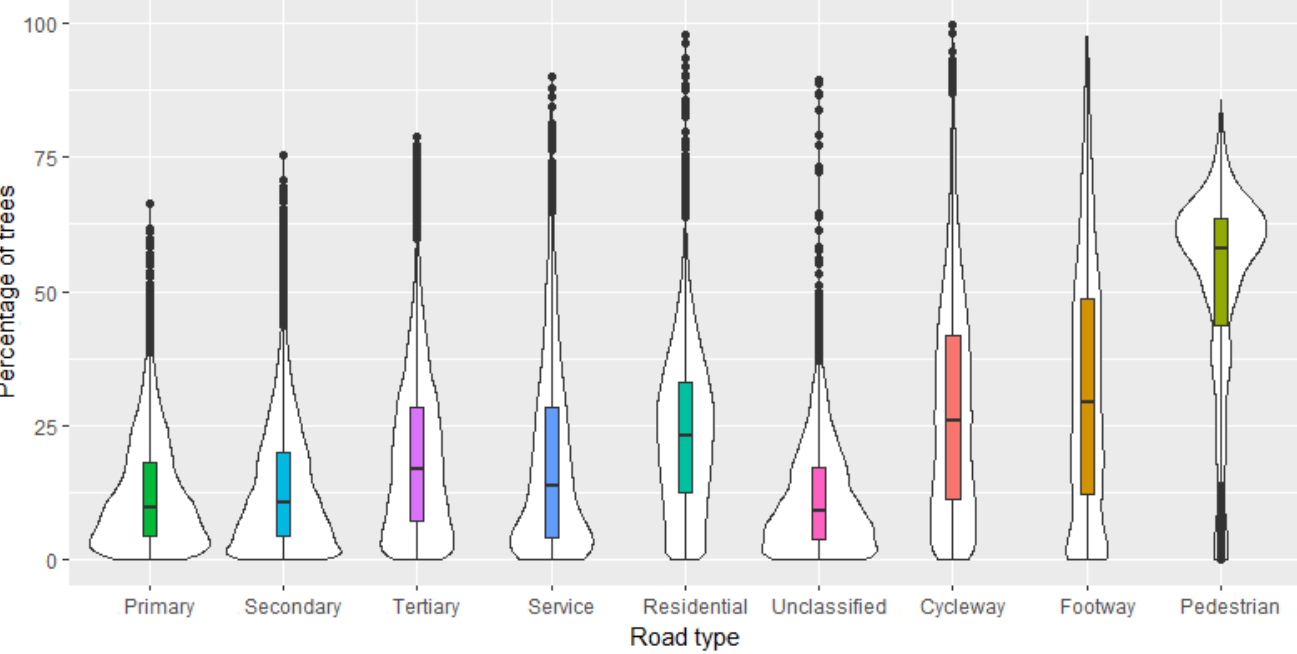
Figure 8. Greenness per road type (i.e., percentage of trees). ANOVA: Welch’s F (8, 311,437) = 6842, p < 0.001, Eta 2 = 0.15. Kruskal–Wallis test: χ 2 ( 8 ) = 39,112, p <